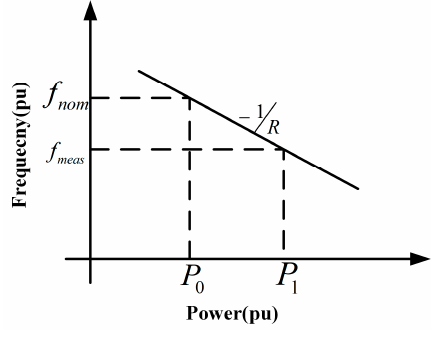
Figure 12. Droop characteristics. Figure 12. Droop